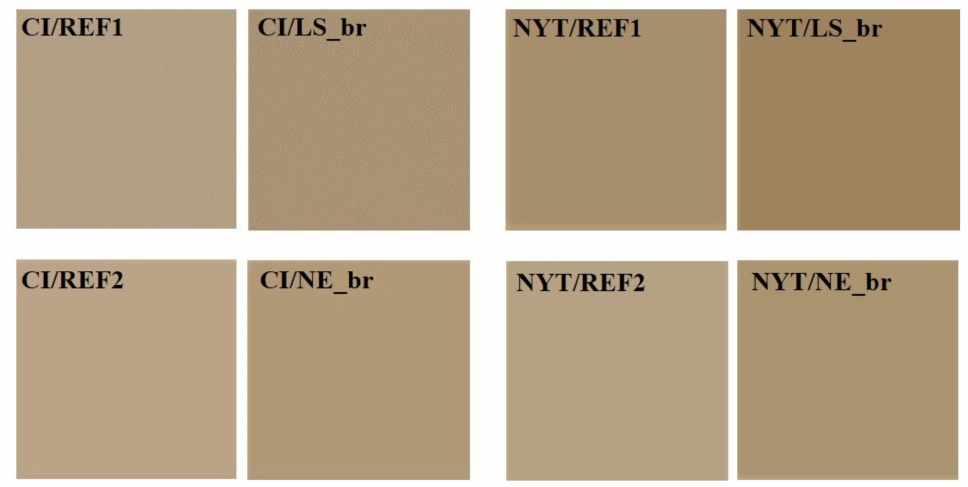
Figure 9. Chromatic variations of untreated and treated CI and NYT samples.